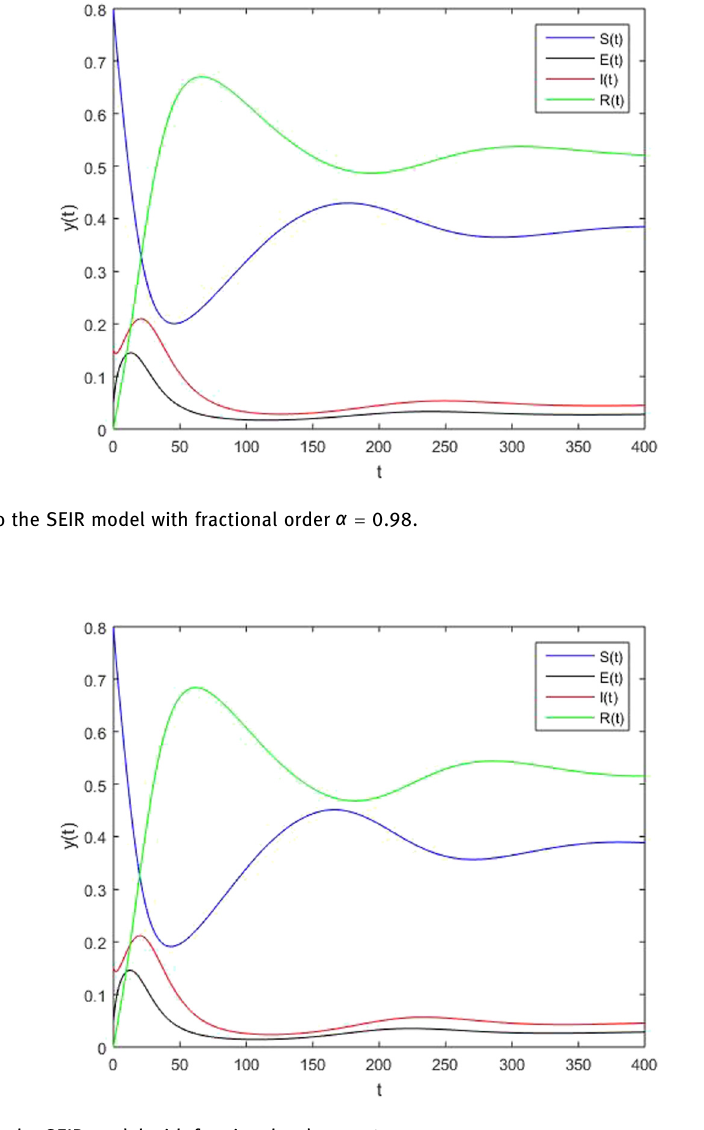
Figure 5: A solution to the SEIR model with fractional order α =